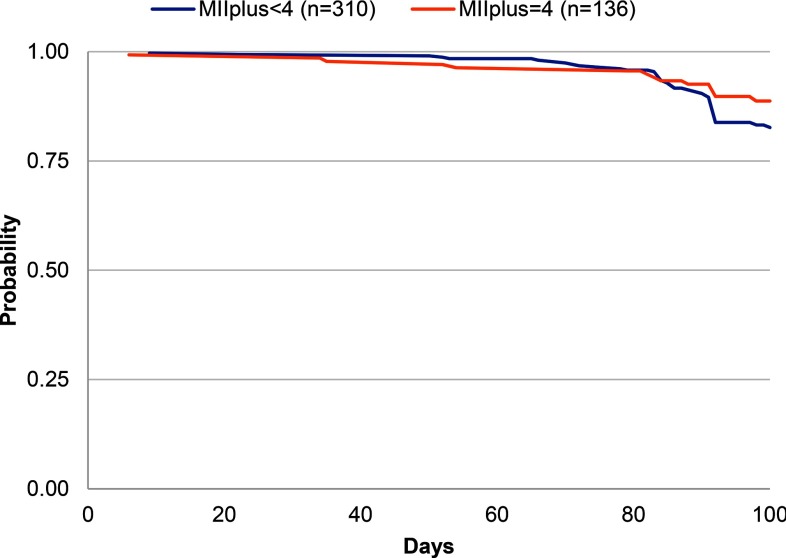
Kaplan-Meier Survival Curves of Contraceptive Continuation by MII With the Added Question About Method Switching (MIIplus) Among Injectable Users at EnrollmentAbbreviation: MII, Method Information Index.